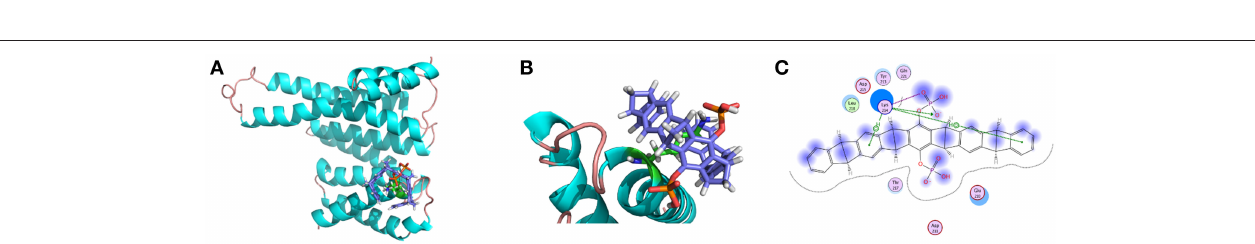
Frontiers in Chemistry |